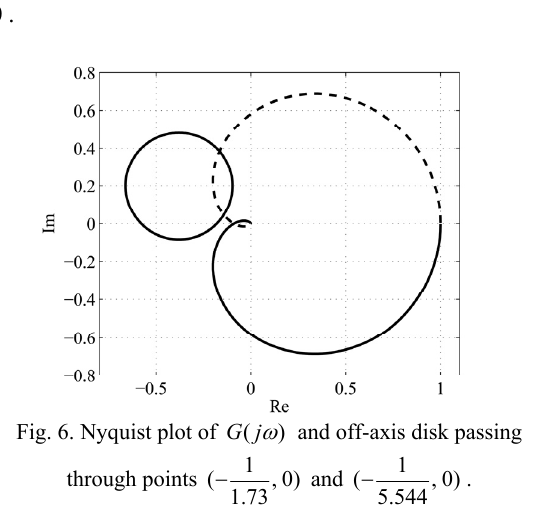
Fig. 6. Nyquist plot of ( ) G j ω and off-axis disk passing 1 through points ( , 0) − and , 0) − . 1.73 5.544